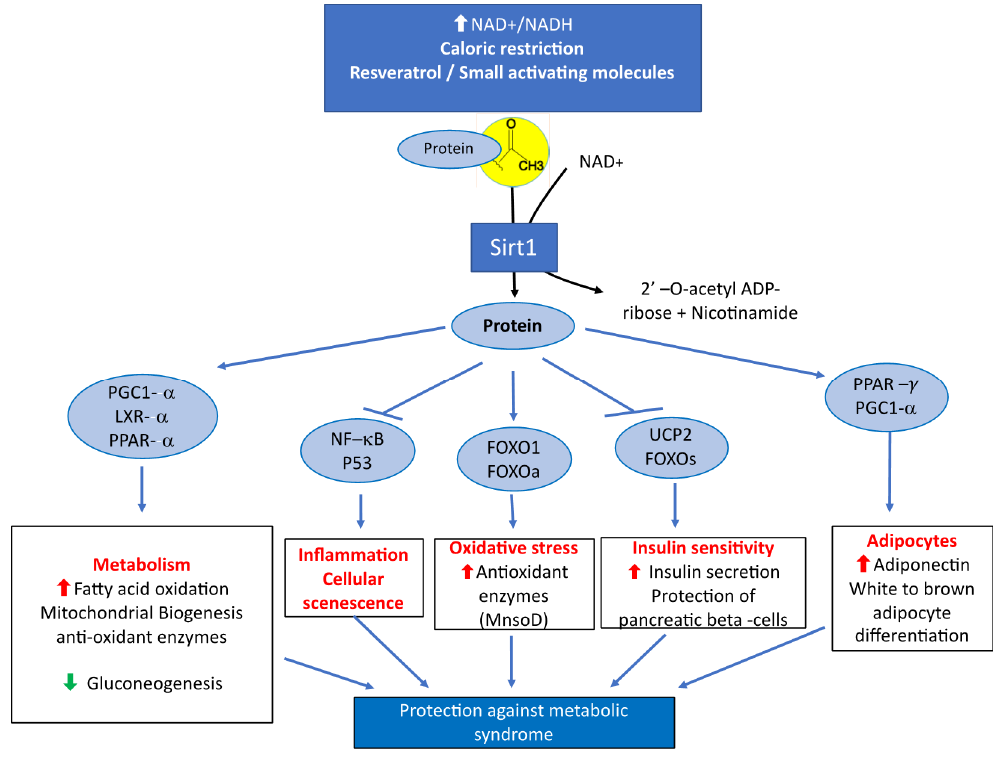
Figure 1. Main metabolic effects of Sirtuin1 related to its protective influence against the manifestations of metabolic syndrome.